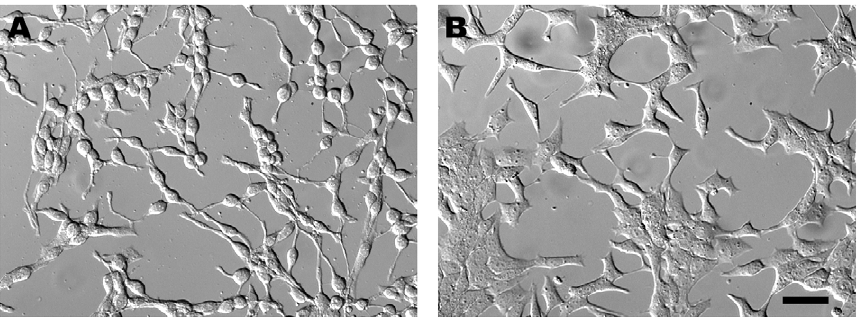
Figure 1. Morphology of CRI-G1 cell lines. A . Parental CRI-G1 cells are rounded, have slender processes, and grow in clumps and ribbons rather than forming an epithelial monolayer. In subsequent text and figures, this phenotype is termed CRI-G1-RR (for explanation of the nomenclature, see Results section.) B . Prolonged culturing at high density conditions leads to a preponderance of cells with surface-adherent, epithelioid appearance that grow in clusters or islands. In subsequent text and figures, this phenotype is termed CRI-G1-RS. Images were acquired by differential interference contrast (DIC) microscopy of living cultures; scale bar, 50 m M.